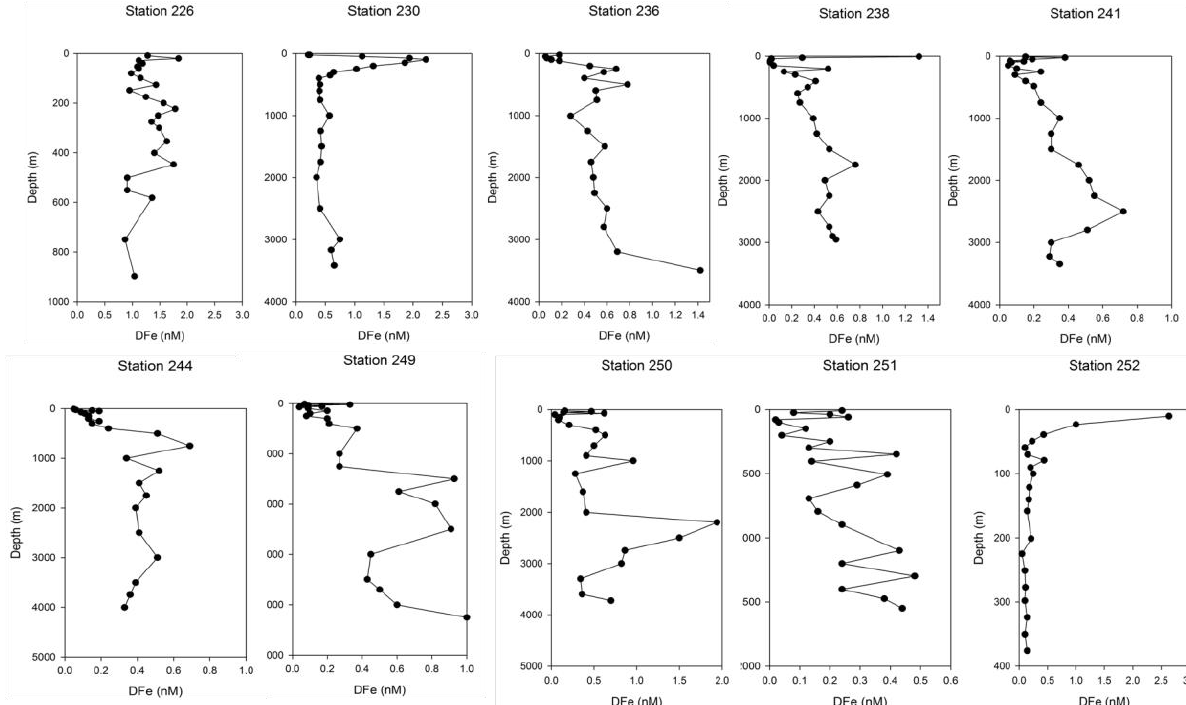
Fig. 5b. Vertical profiles of DFe at individual stations of the transect Drake Passage. Note the different depth and concentration